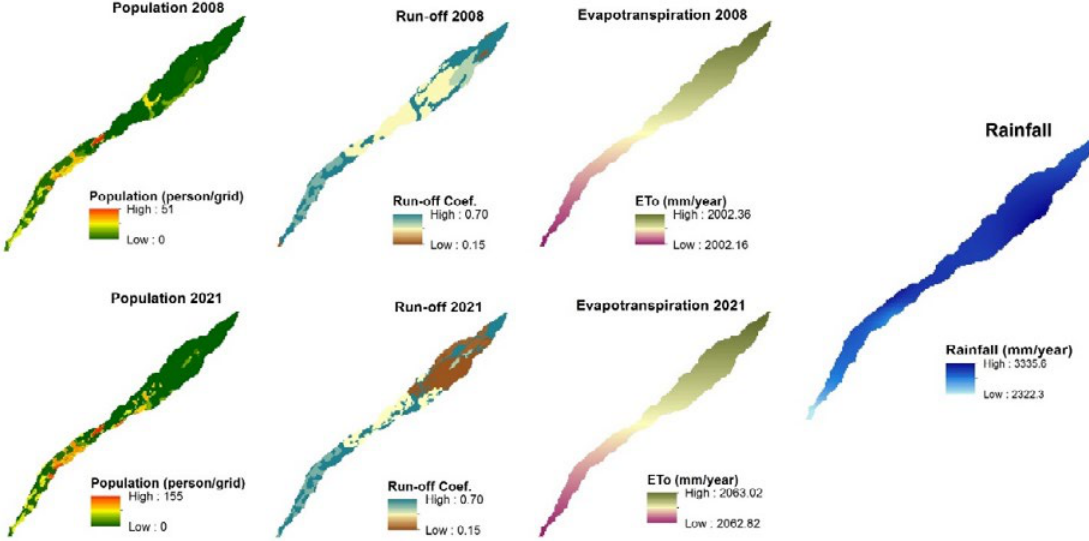
Fig. 2: Changes in WRCC